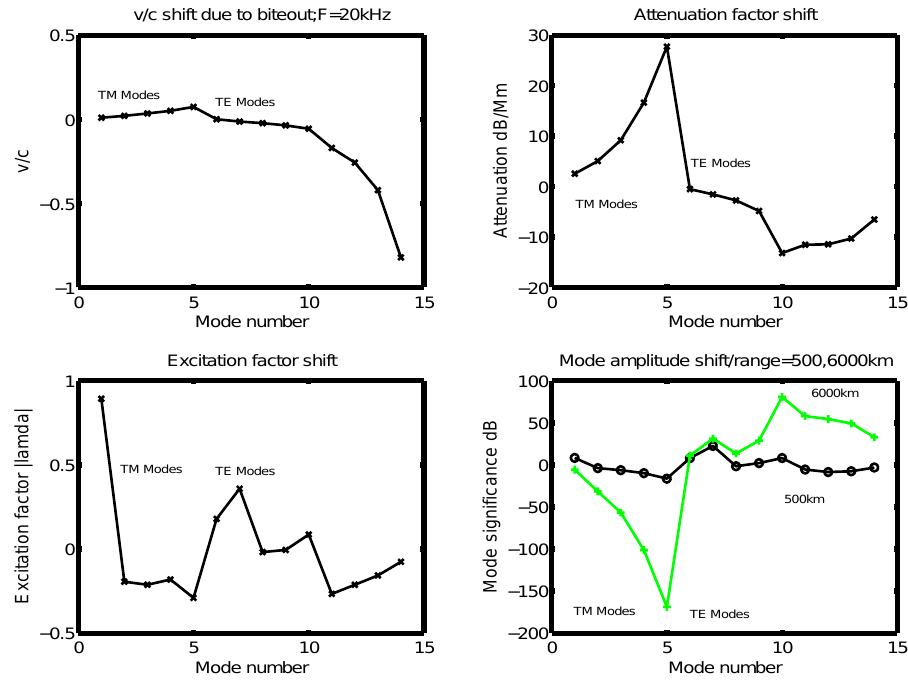
Fig. 3. Perturbations of modal parameters at f =20kHz due to the biteout. The fourth panel shows change in modal composition, where the black line with circles is for a range of 500km and the green line with crosses is for 6000km. Important features are the increased attenuation and increased phase velocity of dominant TM